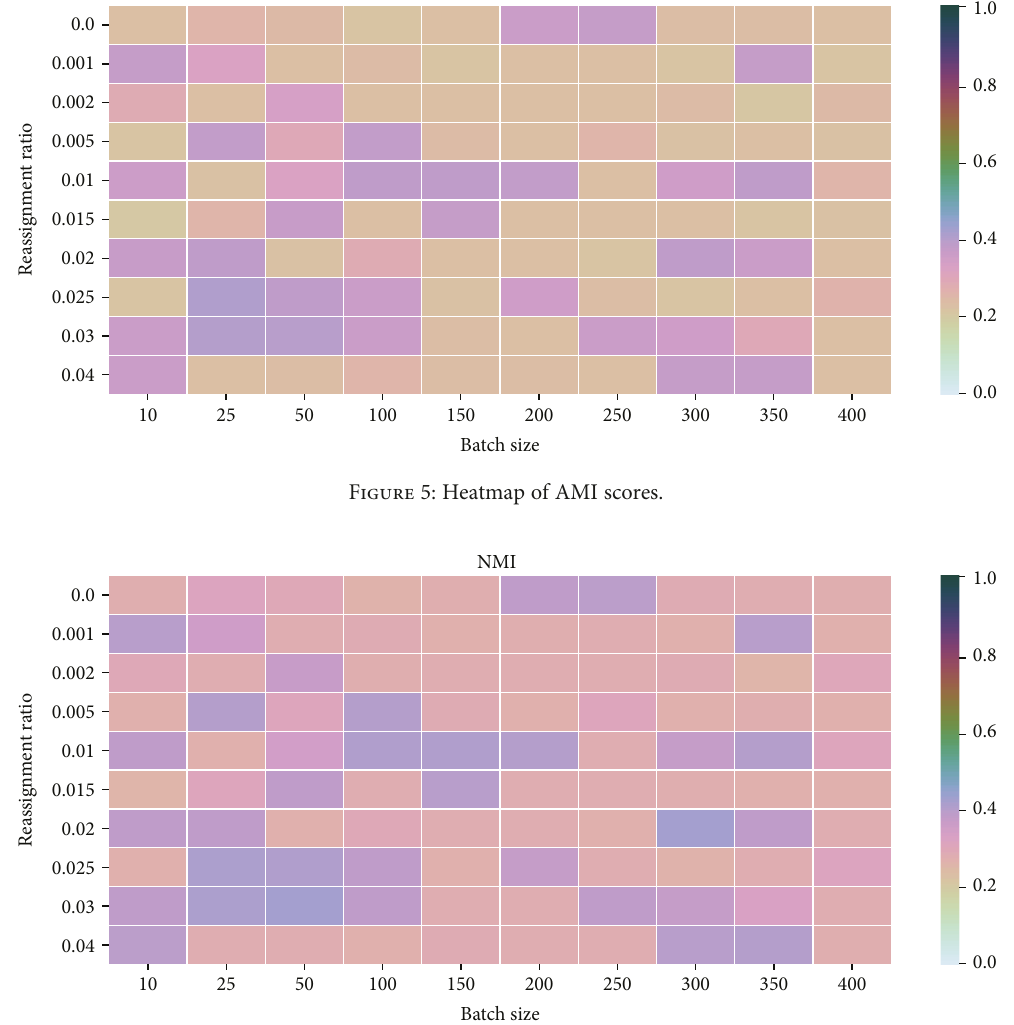
Figure 6: Heatmap of NMI scores.